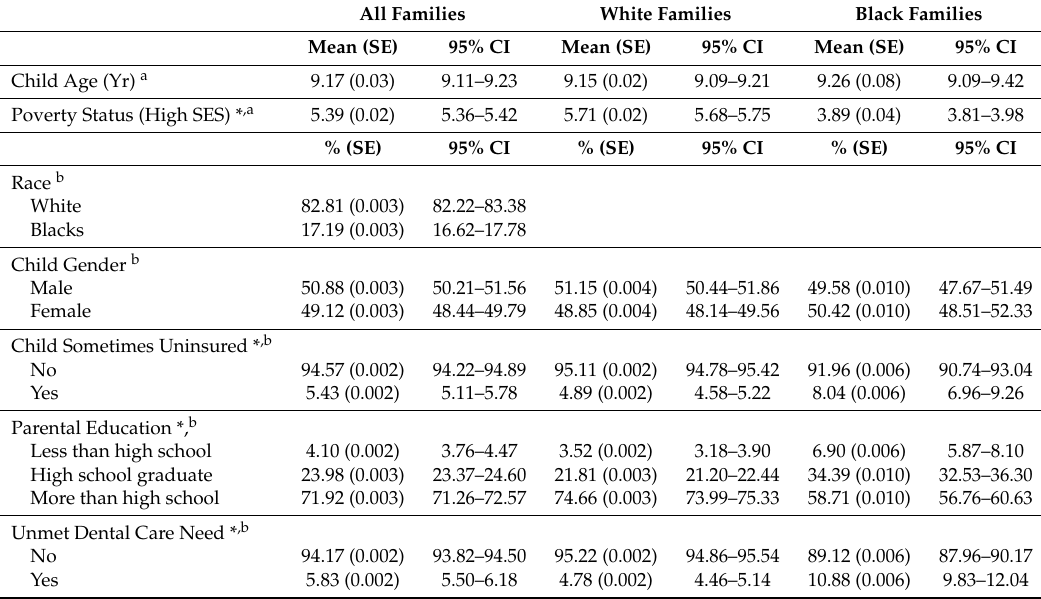
Table 1. Descriptive statistics in the pooled sample, as well as White and Black families.